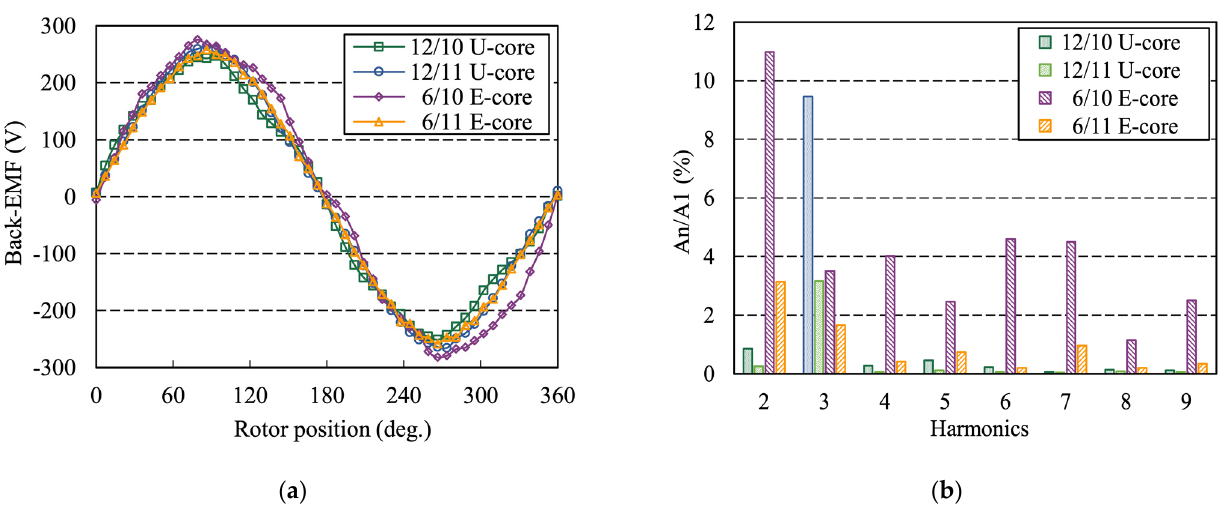
Figure 6. No-load phase back EMF and harmonic distribution of the four candidates. ( a ) Phase back EMF; ( b ) harmonic